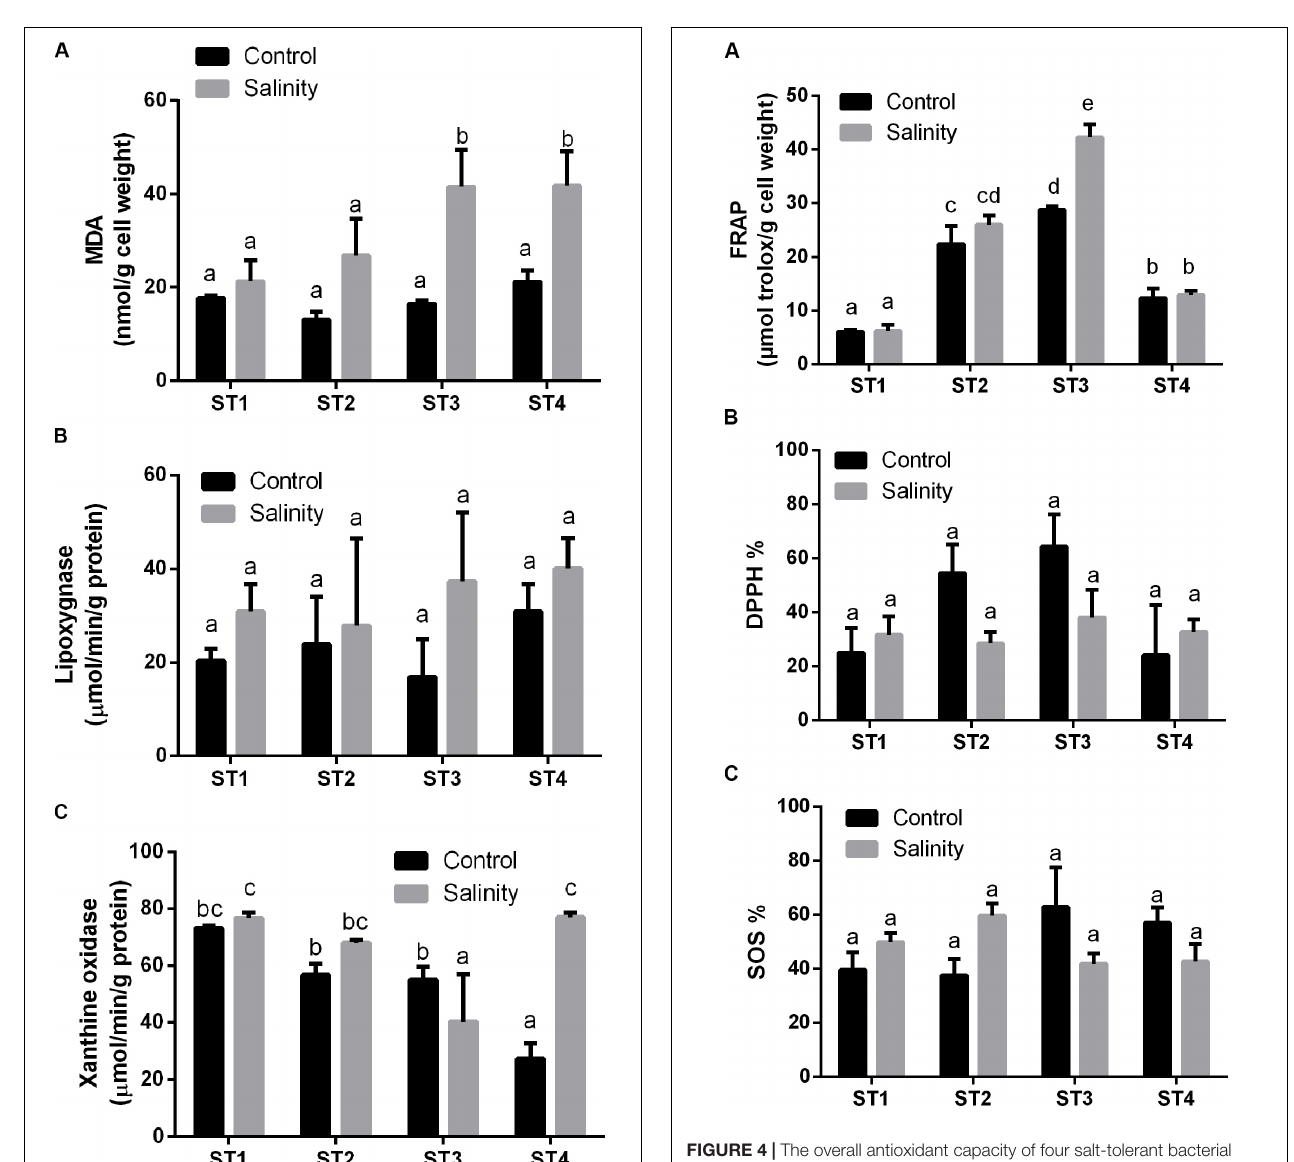
FIGURE 4 | The overall antioxidant capacity of four salt-tolerant bacterial isolates (ST1, ST2, ST3, and ST4) in terms of (A) FRAP, (B) DPPH %, and (C) superoxide scavenging (SOS) under control and salinity stress conditions. Data are represented by the mean of at least three replicates, and error bars represent the standard error. Different small letters (a, b, c ... ) above bars indicate significant differences between means at p <